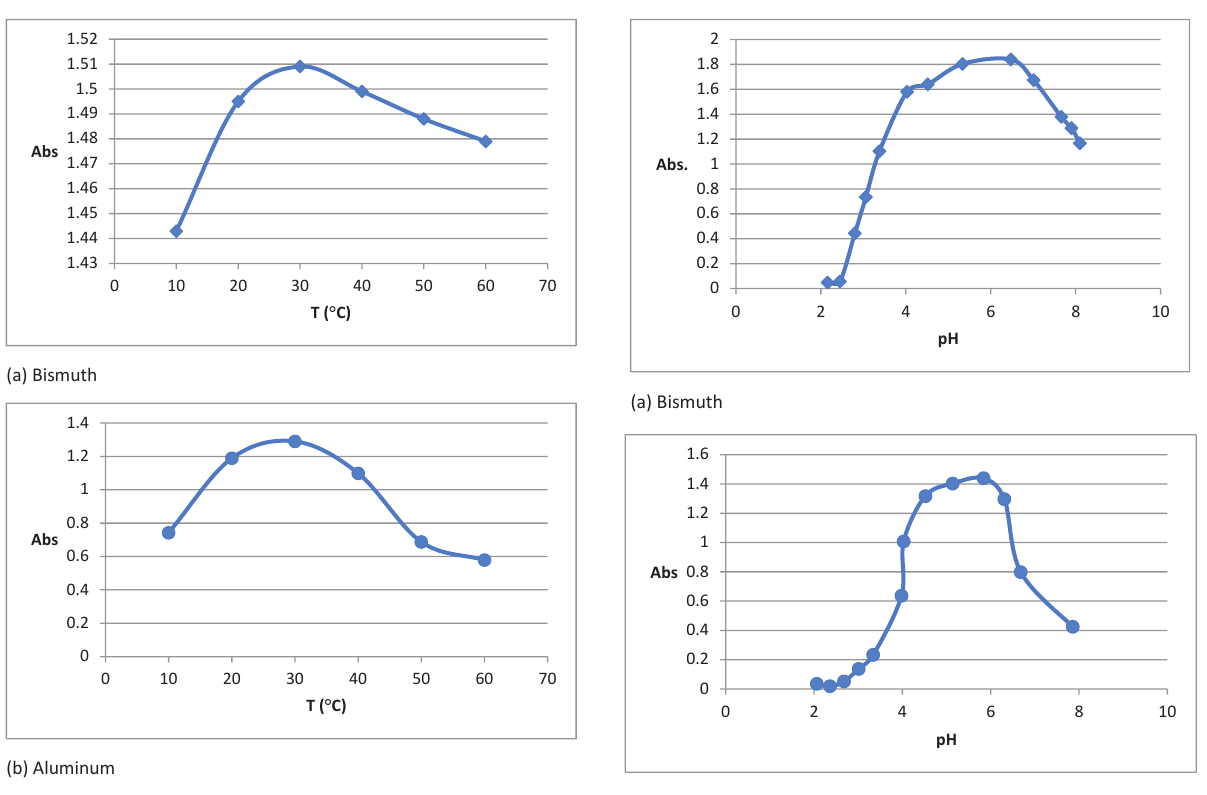
Figure 23: Effect of pH on complex